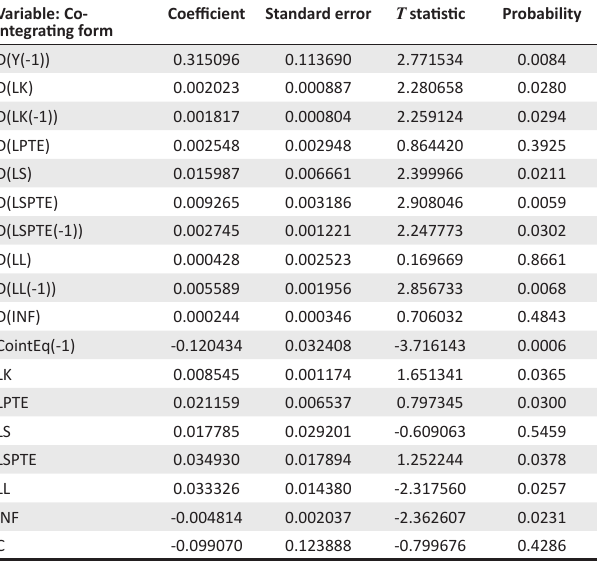
FIGURE 1: Normality test for estimated the panel TABLE 4: Augmented Dickey–Fuller unit root test for Mangaung metro. Variables